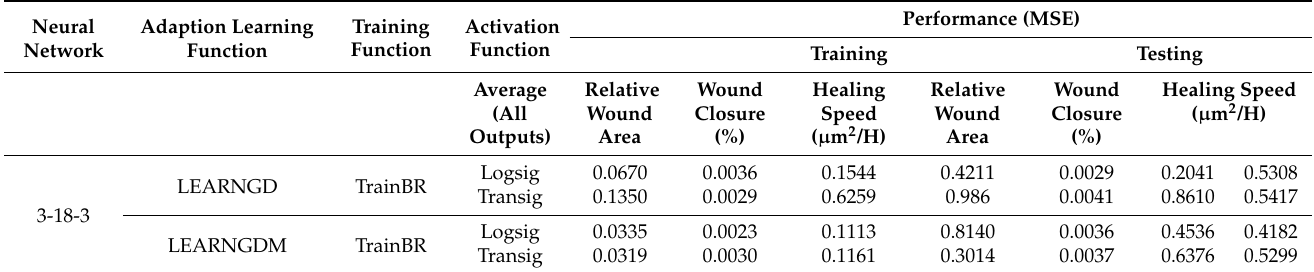
Table 5. The performance comparison of ANN structure with 3-18-3 based on learning and activation functions. Neural Adaption Learning Network Function